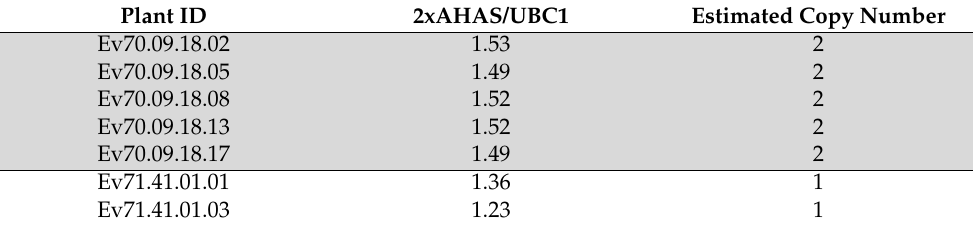
Table 2. Transgene copy number estimated by qPCR in T 2 GM cotton plants. Copy number was estimated by qPCR analysis. A standard DNA curve (1 – 10 − 5 ng) was obtained using a binary plasmid carrying an endogenous reference gene and the transgene against the linear cycle threshold (Ct) values.